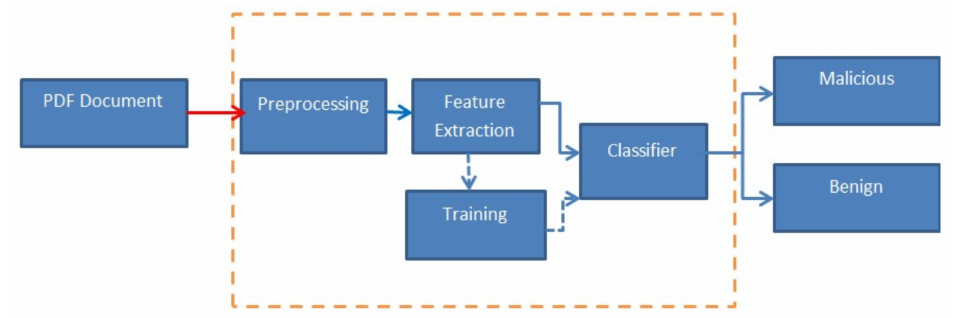
Figure 3. General process flow of machine learning